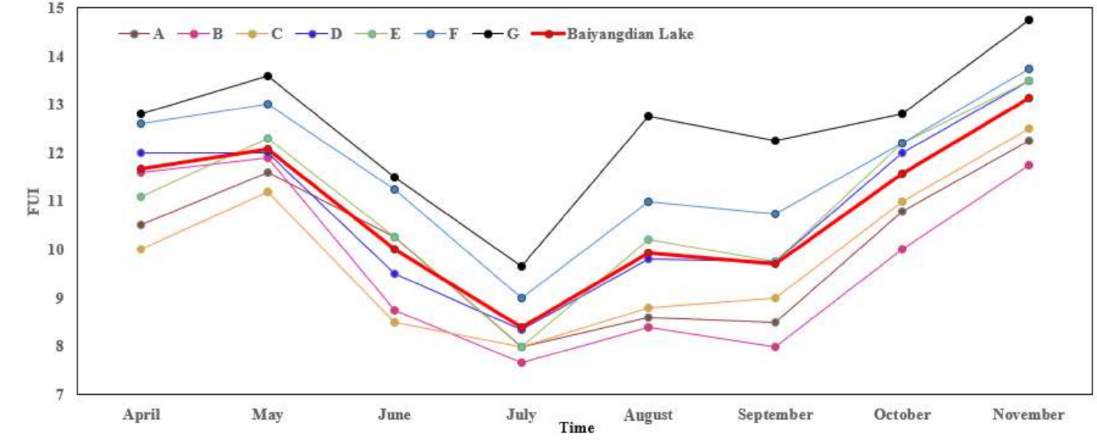
Figure 7. Mean monthly FUI value derived from Sentinel-2 data for the Baiyangdian Lake and its seven